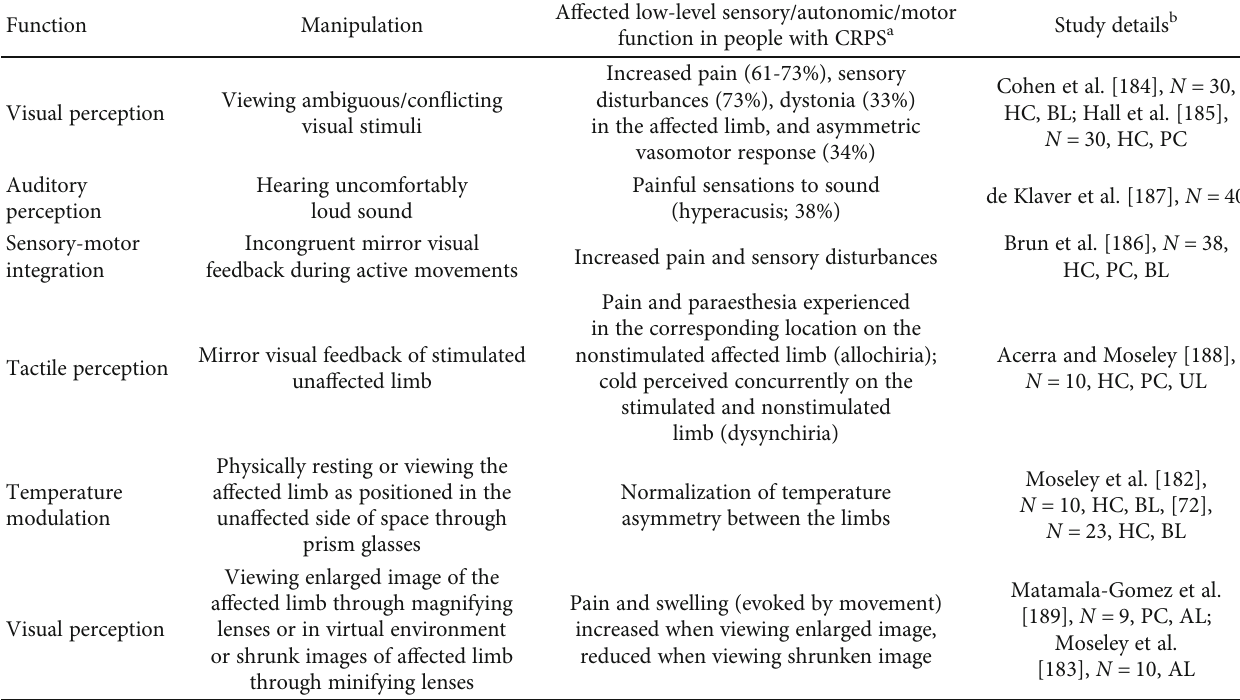
Table 4: Evidence of modulation of low-level sensory and autonomic functions in CRPS by spatial or multisensory manipulations.